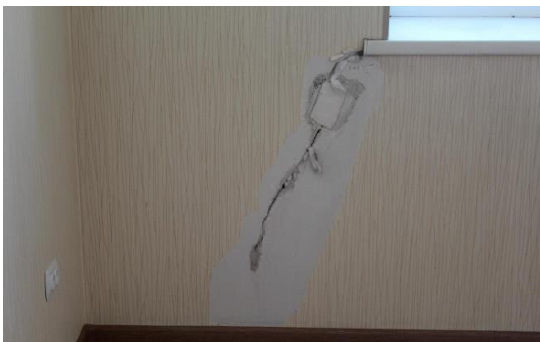
Fig. 6. Examples of cracks that formed in the stress concentration zone in the corner zones of